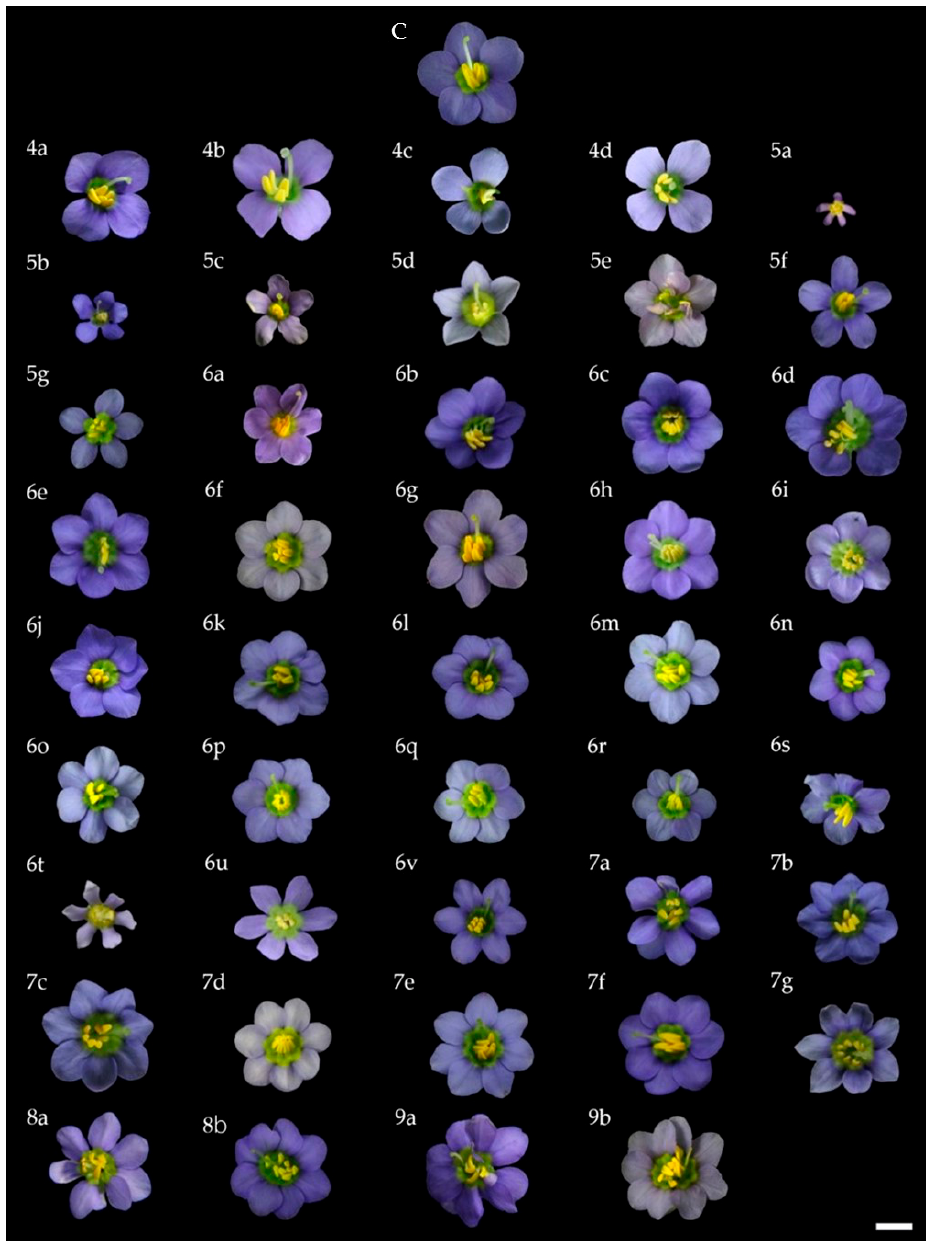
Figure 2. Effect of low- and high-intensity UV-C on Persian violet flower characteristics after irradia- tion and then culturing for 8 weeks: C = control; 4a–4d = 4 petals; 5a–5g = 5 petals; 6a–6v = 6 petals; 7a–7g = 7 petals; 8a–8b = 8 petals; 9a–9b = 9 petals (scale bar = 0.5 cm).